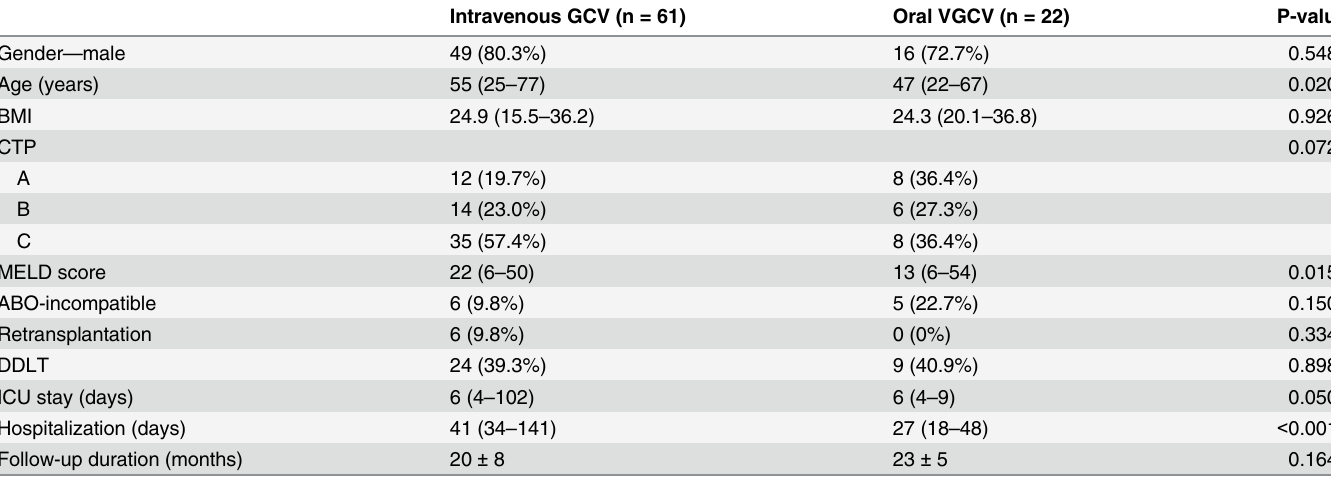
Table 2. Clinical characteristics of patients who received intravenous GCV and oral